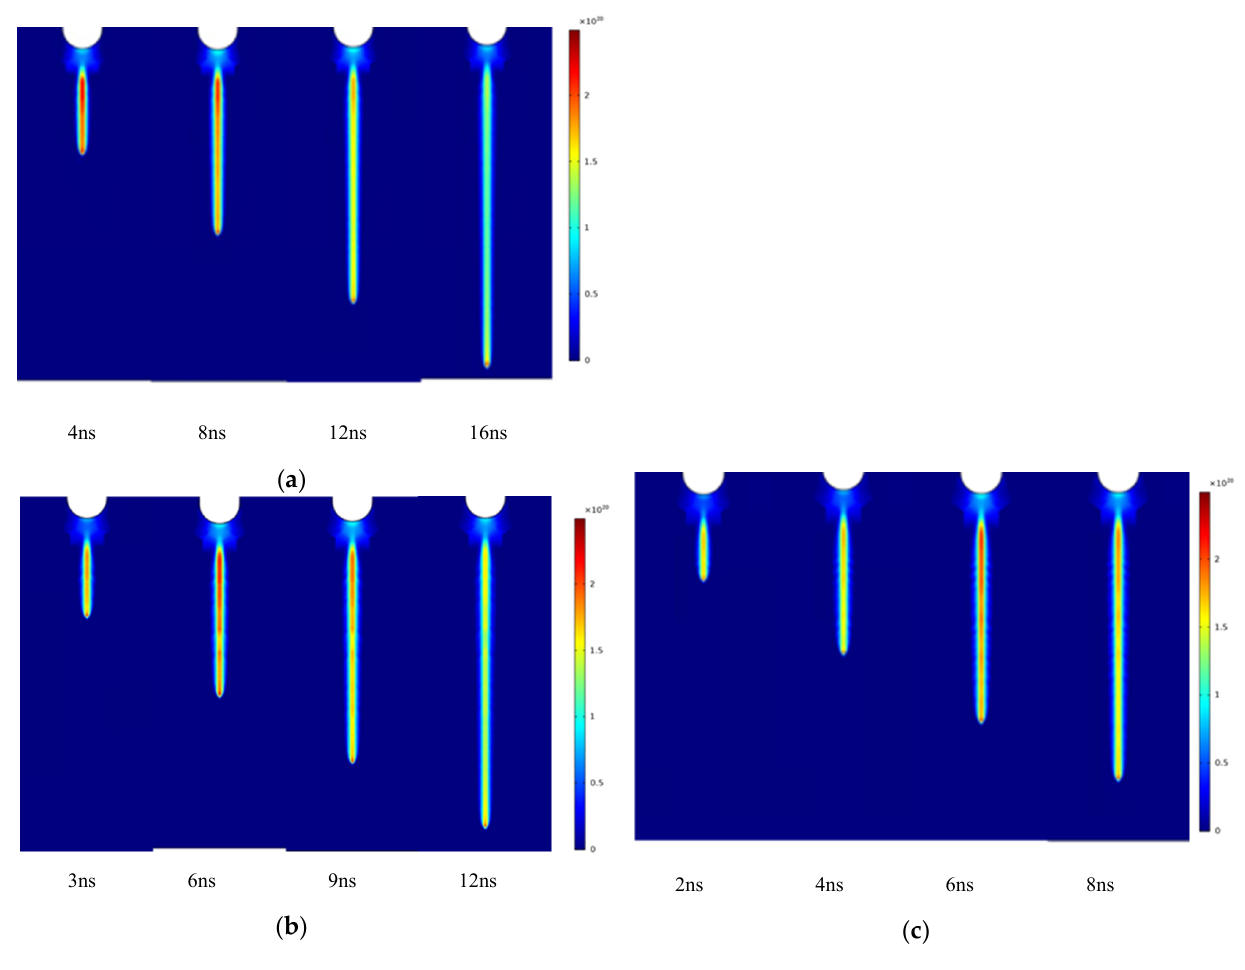
Figure 6. Two dimensional distribution of electron concentration: ( a ) Figure 6. Two-dimensional distribution of electron concentration: ( a ) 101 kPa, ( b ) 85 kPa, ( c ) 70